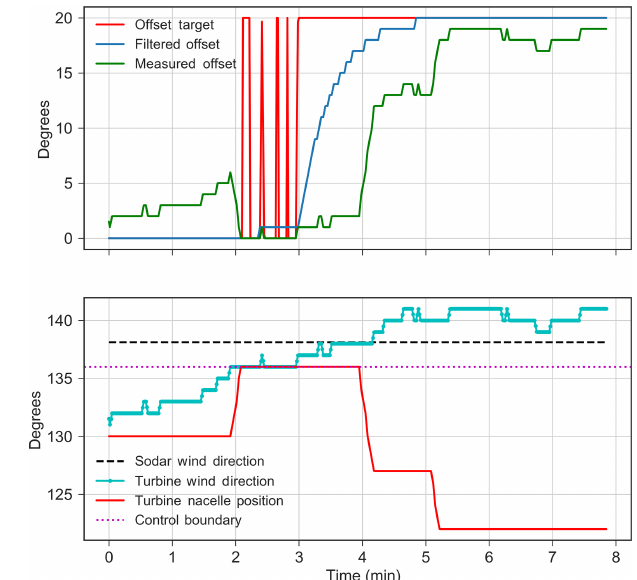
Figure 9. Time series data of T4 operation showing the sources of lag in yaw offset control. The figure shows that following the wind direction entering the range at which a 20 ◦ offset would be optimal at the 2min mark, the offset is not actually achieved until 3min later.